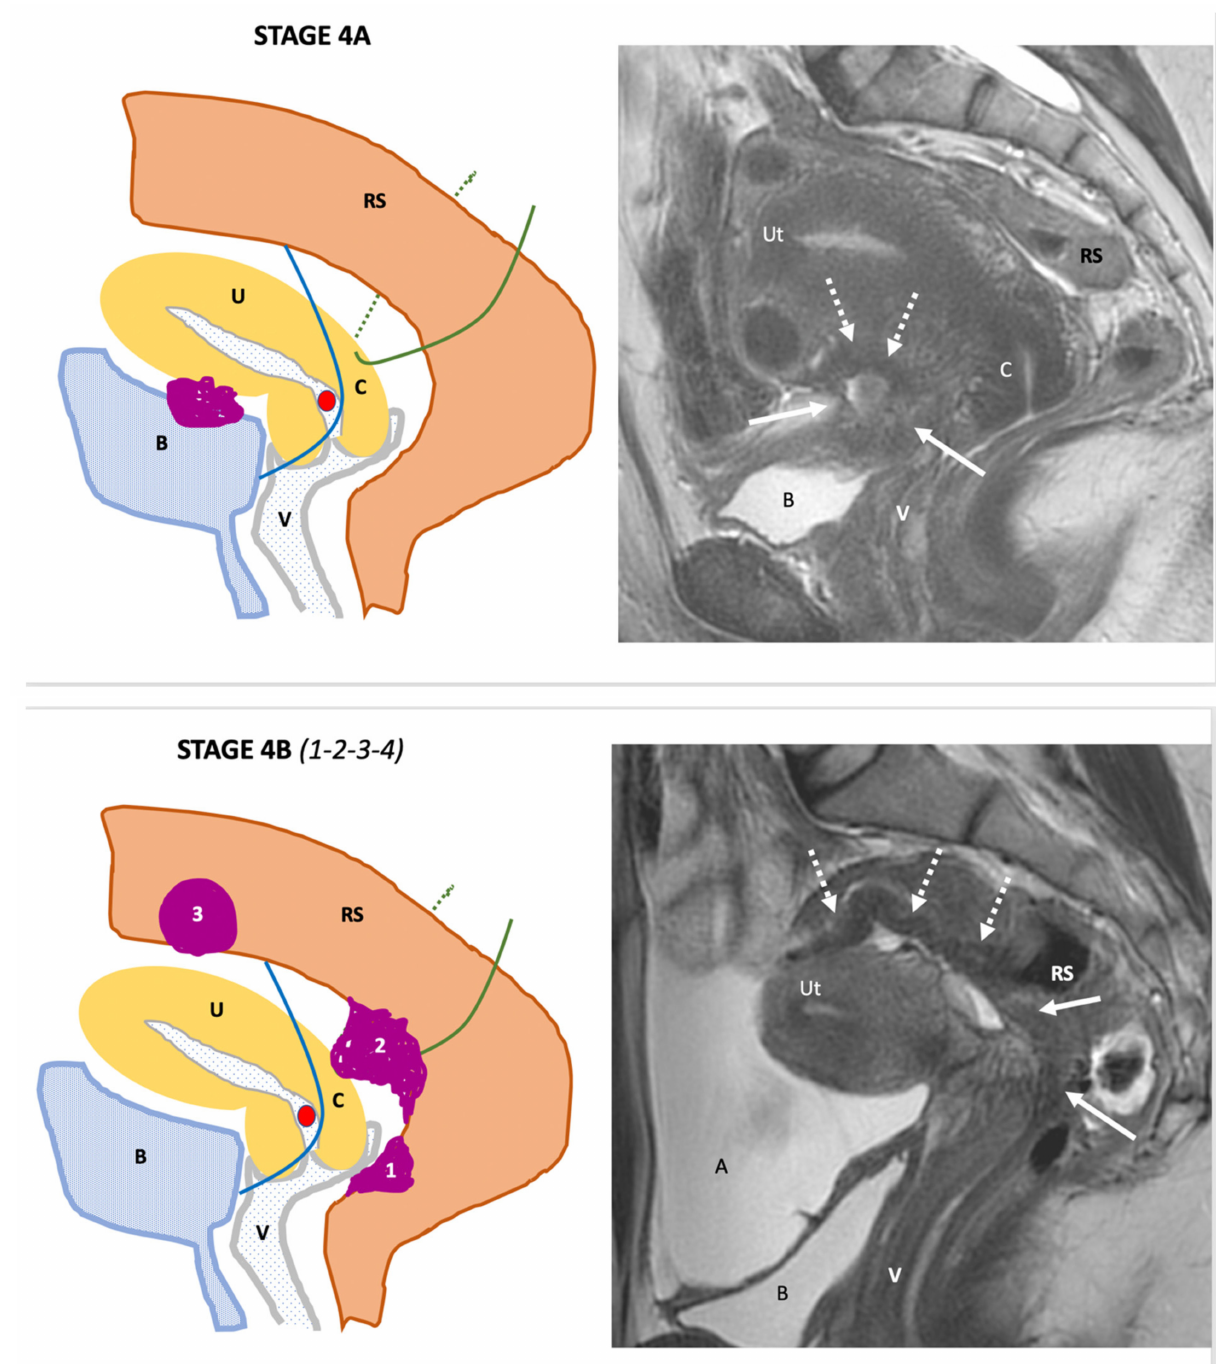
Figure 5. Schematic and example of stage IVA Endo-Stage MRI classification showing the involvement of the vesico-uterine pouch with deep endometriosis involving the bladder ( B ) associated with anterior external adenomyosis (dotted arrows). Schematic (9a) and example (9b) of stage IVB Endo- Stage MRI classification showing the presence of multiple DPE involving the rectosigmoid colon (dotted arrows) and rectum (arrows). Note: ( A ): Ascites, ( B ): bladder, ( C ): cervix, ( RS ): rectosigmoid colon, ( U ): ureter, ( Ut ): uterus; red point: uterine artery, ( V ): vagina. (1,2,3): possible localization of endometriosis